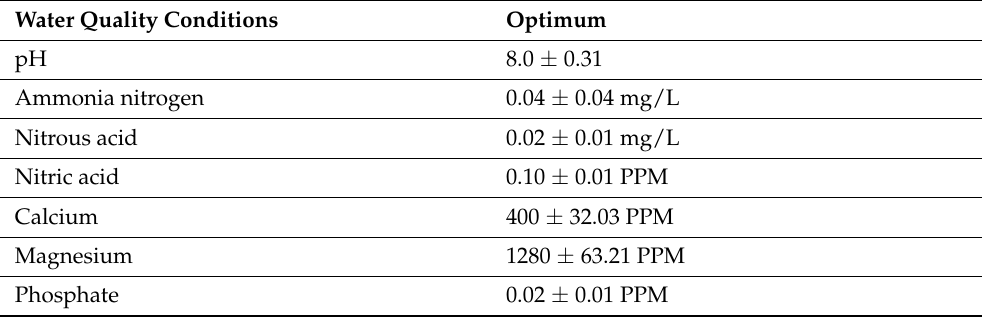
Table 1. The water quality conditions in the study (SD ± 56